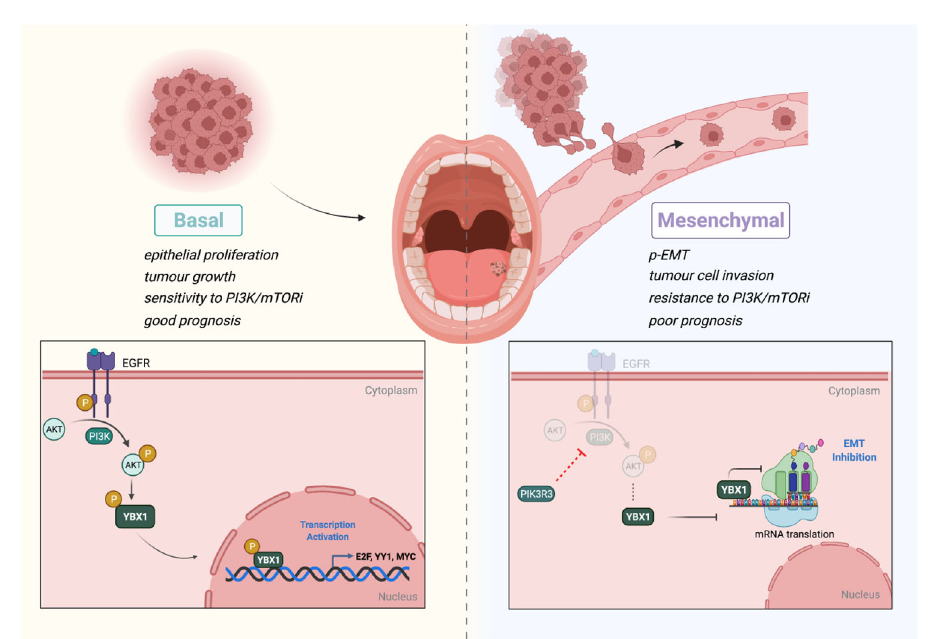
Fig.7|SchematicdiagramdepictingthePI3K-phospho-YBX1proliferationaxis in HNC. Oncogenic activation of PI3K signalling induces phosphorylation of YBX1 andnucleartranslocationtopromotecellularproliferation.InactivePI3Ksignalling